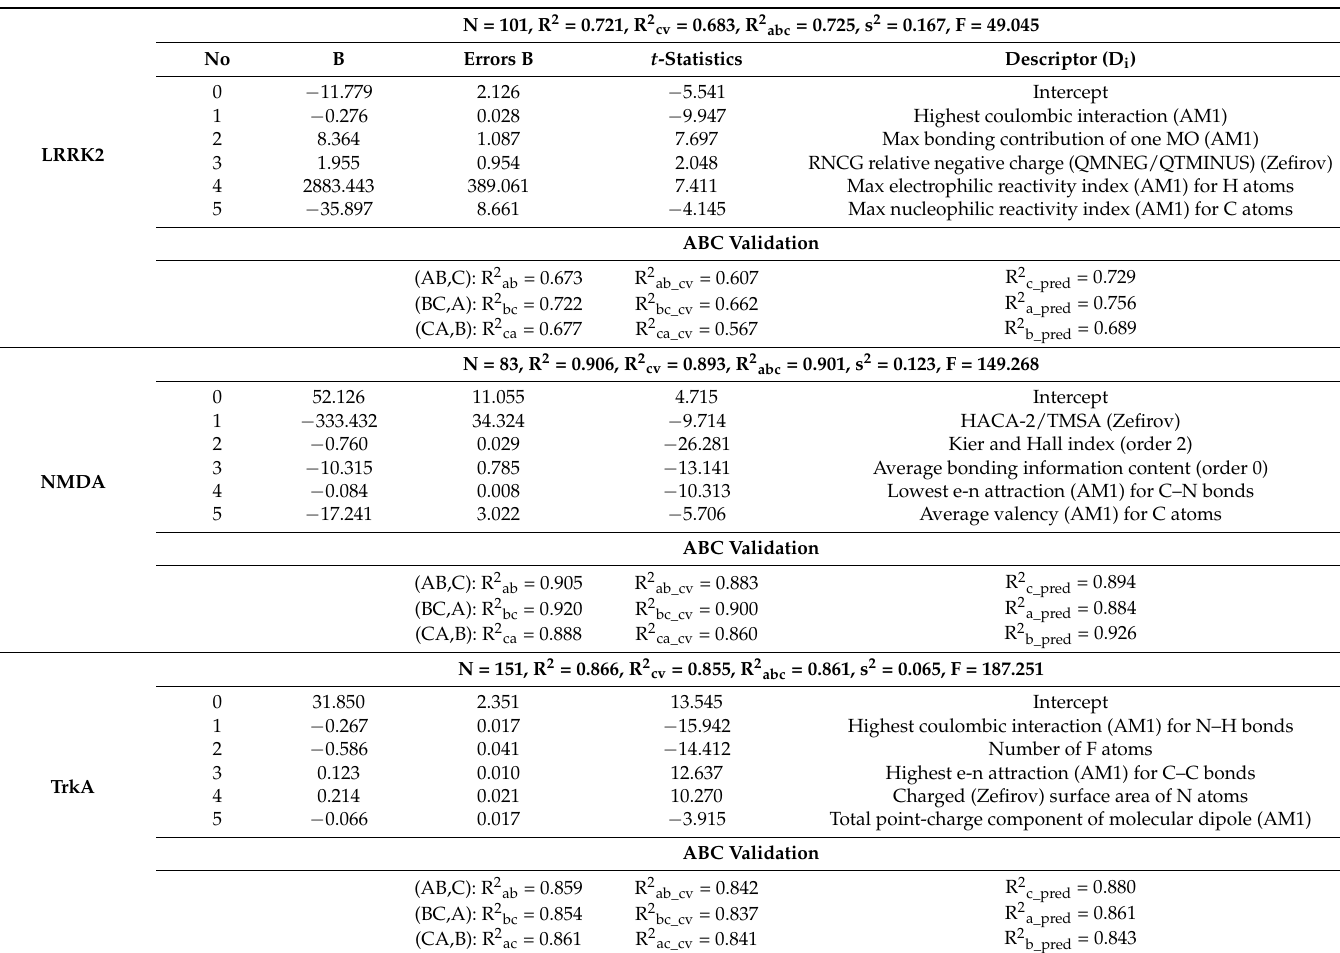
Table 2. Best multilinear regression (BMLR) models for logIC 50 and their statistical